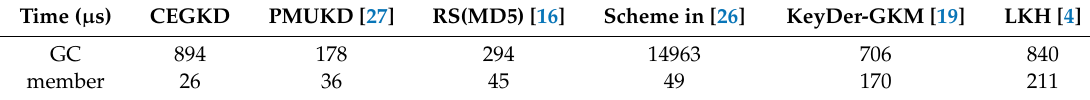
Figure 3. Group-member computation cost. Table 5. Computation time compared to other schemes (multicast-group size of